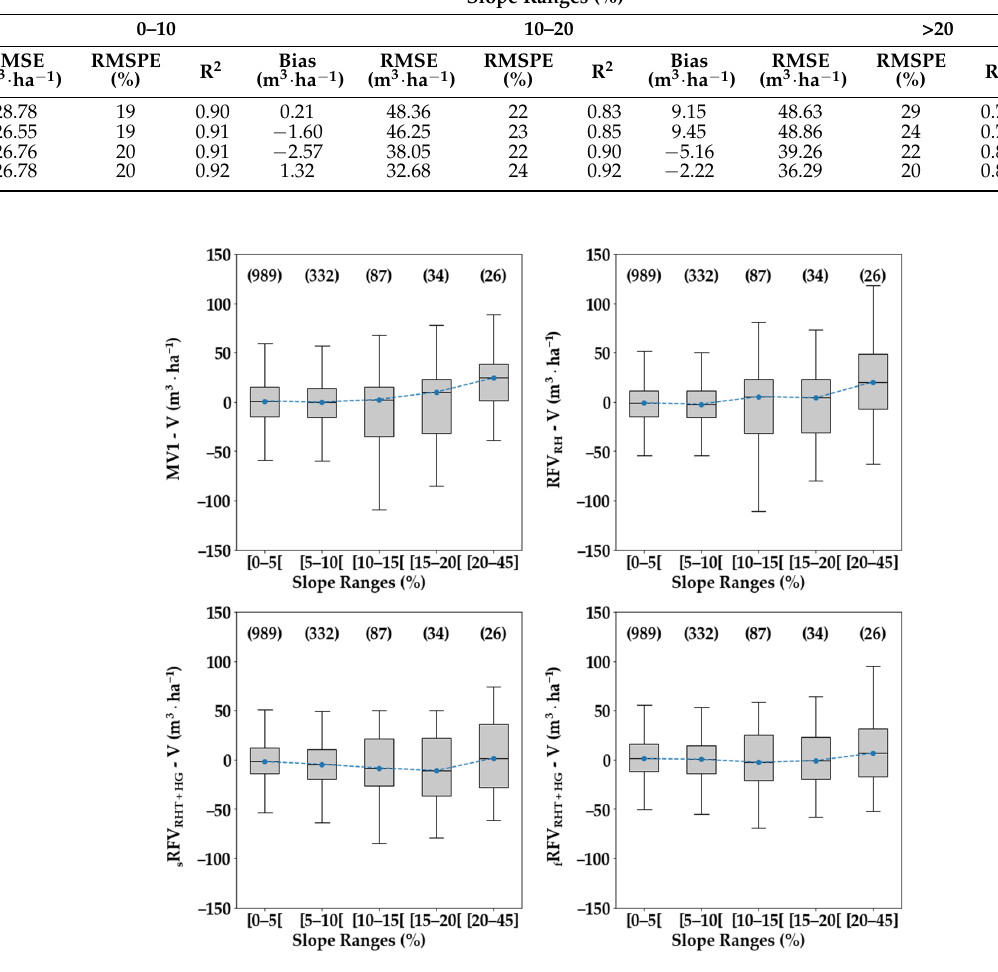
Figure 10. Box-whiskers plots of the difference between the estimated and in situ 𝑉 using four estimation models across five slope ranges. Numbers in parenthesis represent the number of points in each slope class.